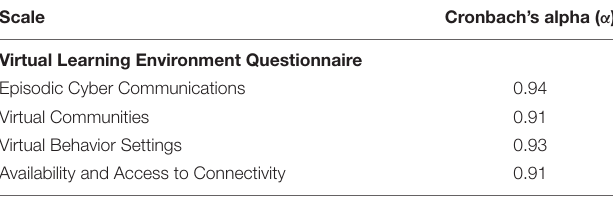
TABLE 1 | Internal consistency of the scales.